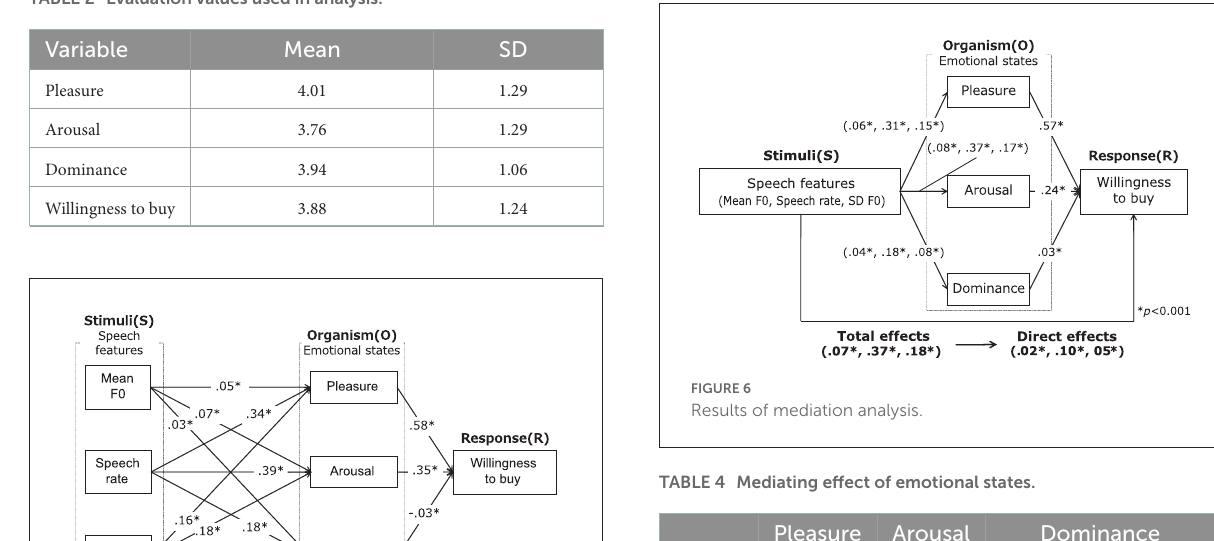
TABLE 2 Evaluation values used in analysis.